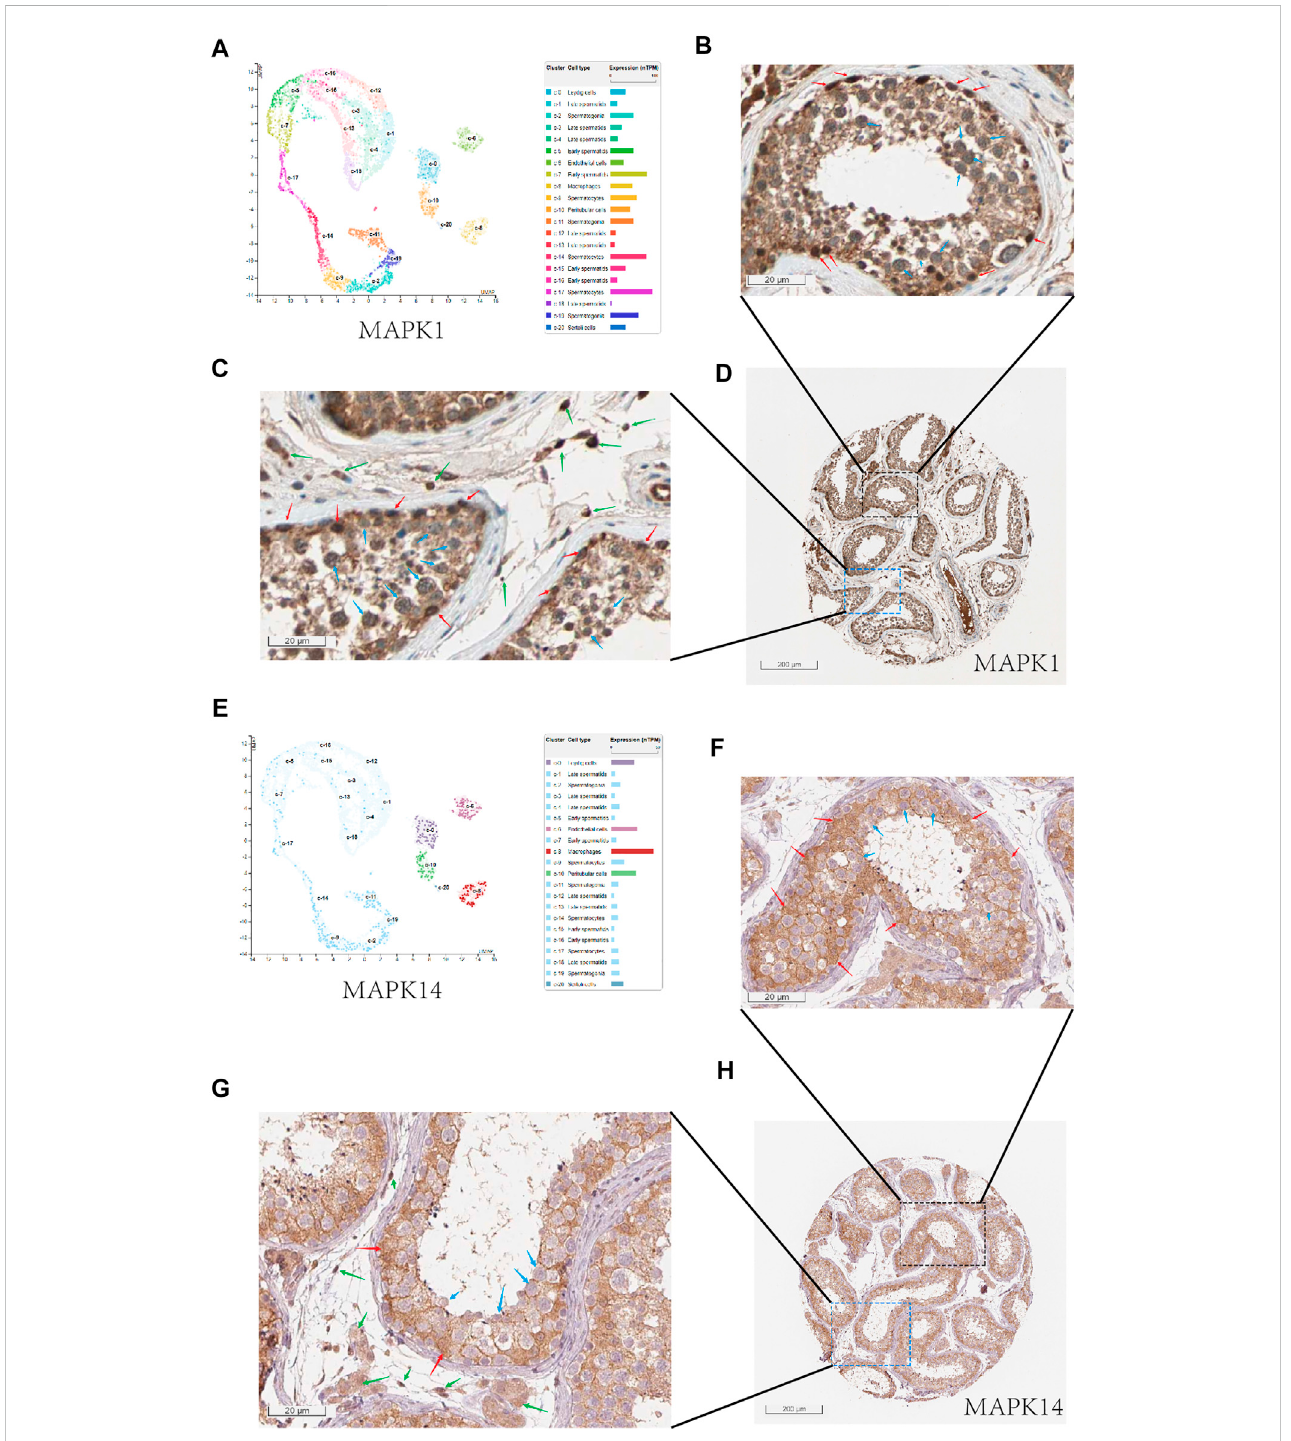
FIGURE 6 The expression of MAPK1 and MAPK14 in spermatogenic tubules. (A) Through the single cell analysis of HPA online website, it can be seen that MAPK1 is mainlyexpressedinsertolicells,leydigcells,andspermatogeniccellsinthehumannormaltestis. (B) Throughthehumanproteinexpressionanalysiswebsiteof HPA online website, it can be seen that MAPK1 is mainly expressed in sertoli cells (red arrow) and spermatogenic cells (blue arrow) in the human normal testis (400x). (C) anditcanbeseenthatMAPK1ismainlyexpressedinleydigcells(greenarrow)andspermatogeniccells(bluearrow)inthehumannormaltestis (400x). (D) Overall expression of MAPK1 protein in seminiferous tubules (10x). (E) Through the single cell analysis of HPA online website, it can be seen that MAPK14 is mainly expressed in leydig cells and sertoli cells in the human normal testis. (F) Through the human protein expression analysis website of HPA online website, it can be seen that MAPK14 is mainly expressed in sertoli cells (red arrow) in the human normal testis (400x). (F) and it can be seen that MAPK14 is mainly expressed in leydig cells (green arrow) in the human normal testis (400x). (G) Overall expression of MAPK14 protein in seminiferous tubules (10x). (H) Overall view of the MAPK14 expression of human normal testis